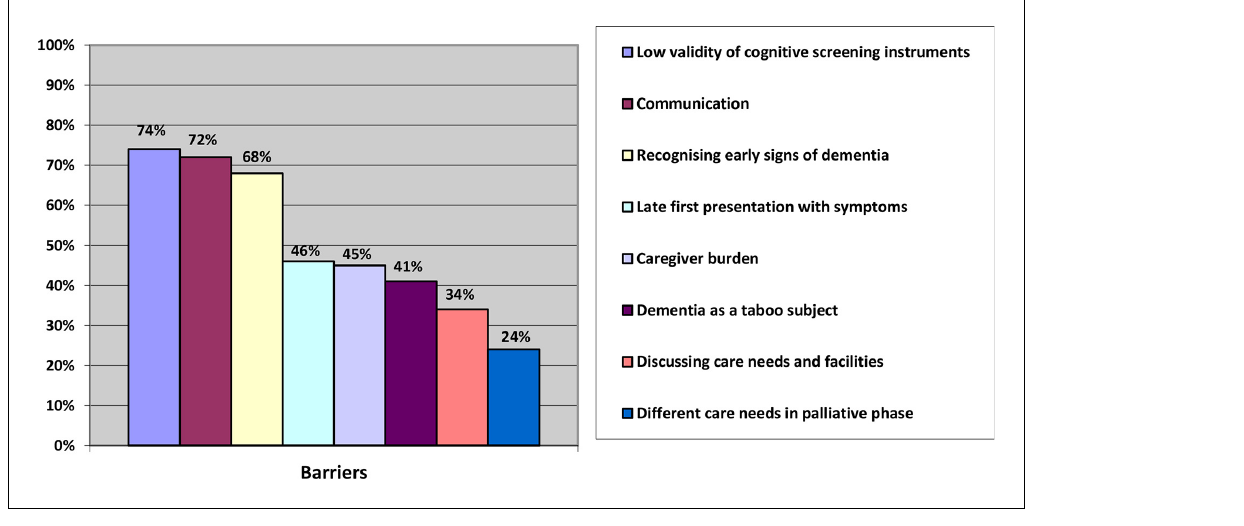
Figure 1. Barriers of providing care to immigrants patients with dementia reported by GPs ( n = 76)